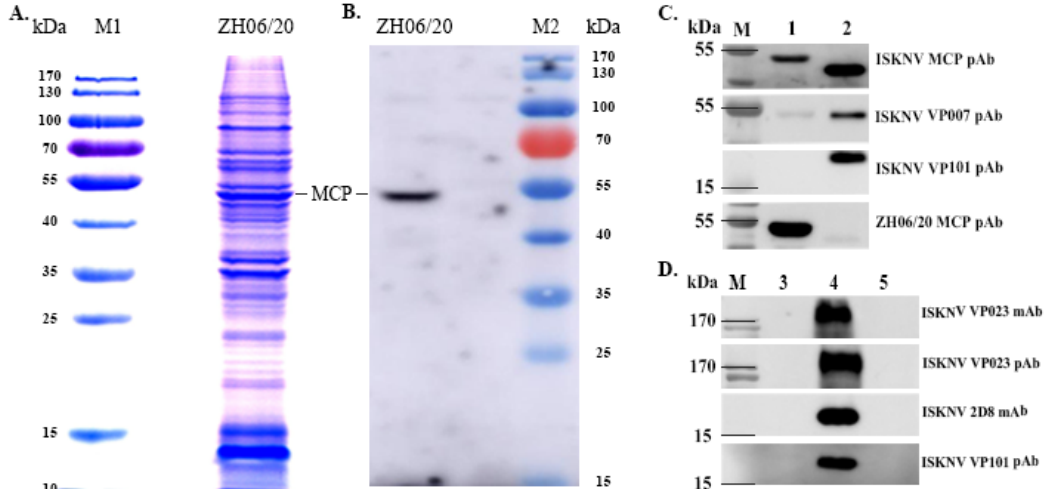
Figure 6. ( A , B ) Viral protein of the purified ZH ‐ 06/20. ( A ) Protein profile of the crude purification of ZH ‐ 06/20 by SDS ‐ PAGE. ( B ) Western blot analysis of ZH ‐ 06/20 proteins recognized by anti ‐ recombinant MCP pAb of ZH ‐ 06/20. ( C , D ) Cross ‐ reaction between ZH ‐ 06/20 and ISKNV using different anti ‐ ISKNV and anti ‐ ZH ‐ 06/20 antibodies by western blot analysis. ( C ) The purified ZH ‐ 06/20 and ISKNV virions were recognized by anti ‐ ISKNV ‐ MCP, ‐ VP007, ‐ VP101, and anti ‐ ZH ‐ 06/20 MCP pAbs. ( D ) ZH ‐ 06/20 and ISKNV ‐ infected MFF ‐ 1 cells were recognized by anti ‐ ISKNV VP101 and VP023 pAbs and anti ‐ ISKNV 2D8 and VP023 mAbs. M: marker; Lane 1–2: Purified ZH ‐ 06/20 and ISKNV; Lane 3–5: ZH ‐ 06/20, ISKNV, and mock infected ‐ MFF ‐ 1 cells, respectively. pAb, poly ‐ antibody; mAb, monoclonal antibody.